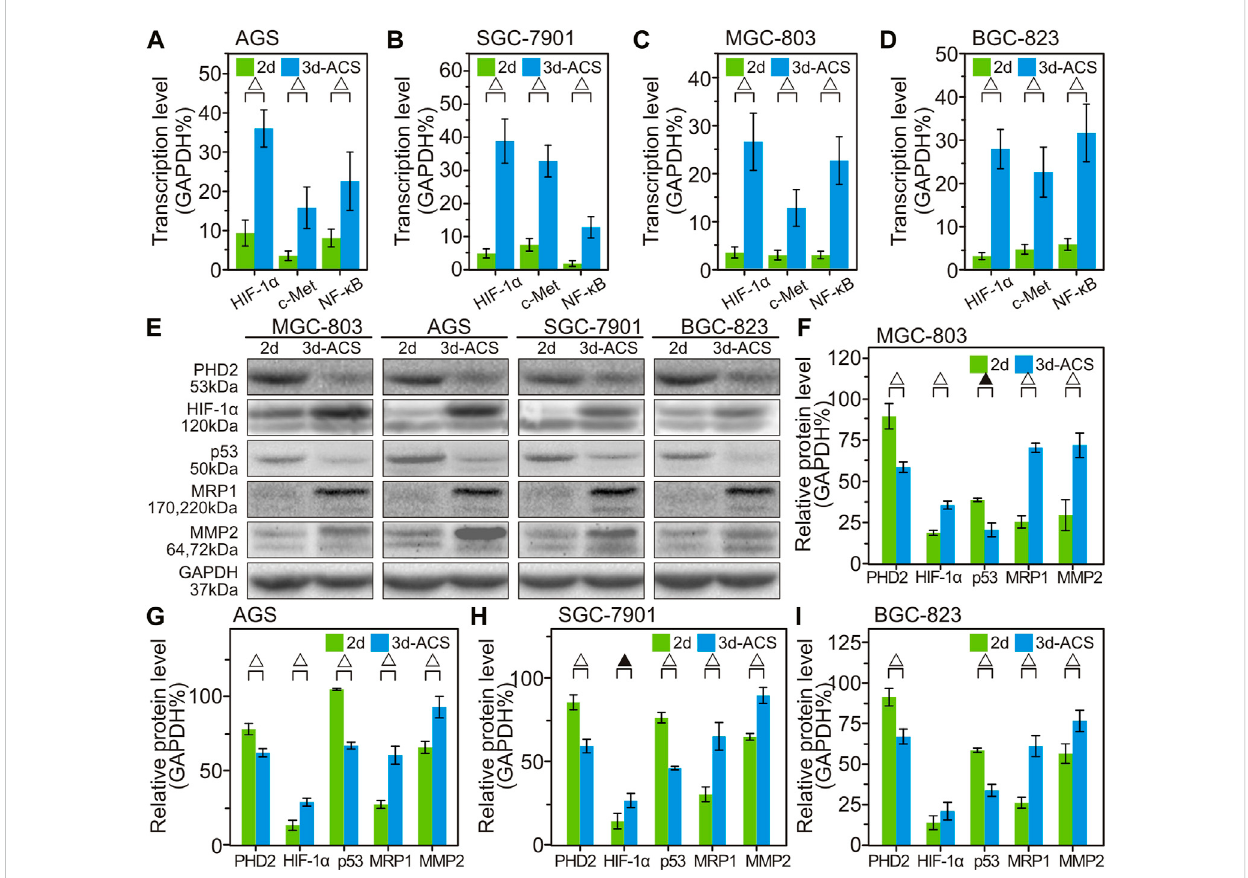
FIGURE 6 The variation of gene transcription and protein expression in 3d-ACS and 2d culture. (A – D) Quantitative analysis of the qPCR data of HIF-1 α gene expression (percent of GAPDH) and related changes to cell proliferation, metastasis, and drug resistance in several GC cell lines within 3d-ACS and